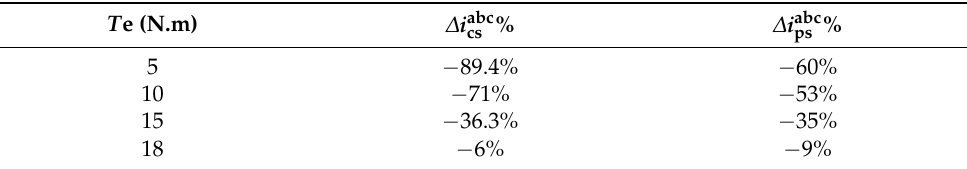
Table 3. Current comparison between two control methods of MTPA-(SFV-FLC) and (SFV-FLC) when the torque changes.